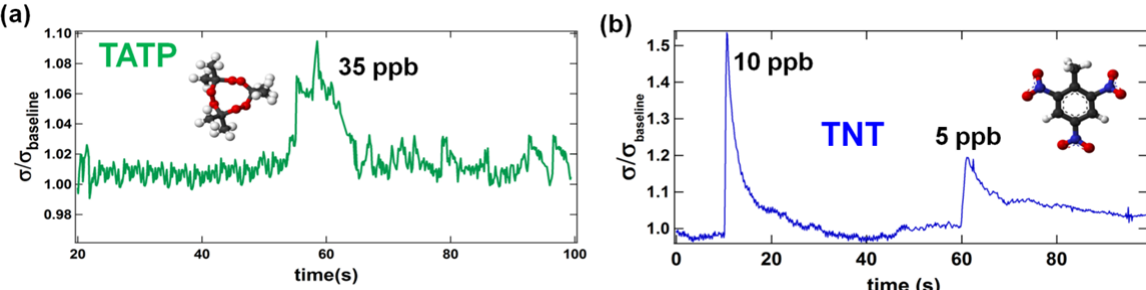
Figure 3. ( a ) The relative change in conductance of a thermally activated Pd/ZnO nanospring sensor upon exposure to TATP at 35 ppb and an exposure pulse of 0.1 ms; ( b ) The relative change in conductance of a thermally activated Pd/ZnO nanospring